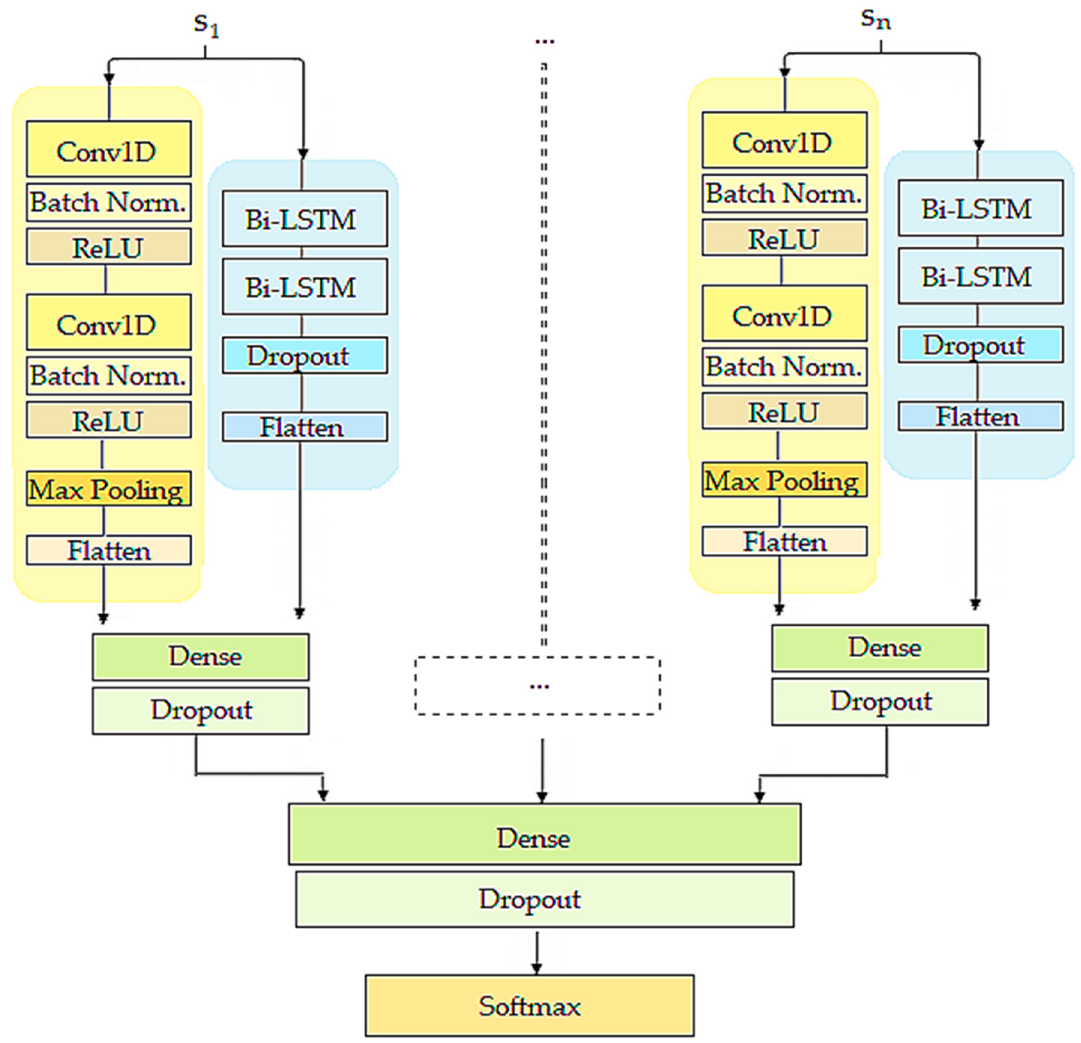
Figure 4. Proposed architecture for gait abnormalities detection—each sensor signal is processed by a dedicated channel consisting of a convolutional neural network (CNN) and a bidirectional long short-term memory (LSTM) network. The architecture utilizes feature-level fusion of multiple sensor signals.